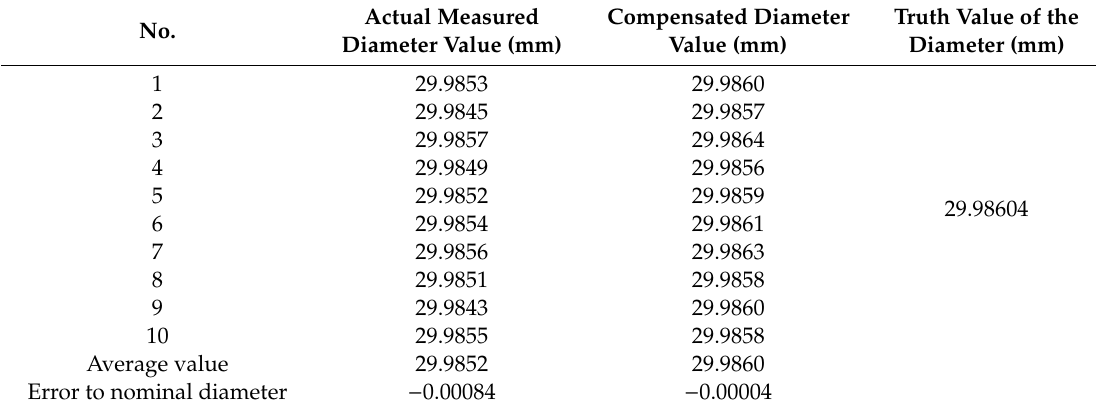
Table 1. The experimental data of the diameter of the standard sphere measured by the coordinate measuring machine (CMM) with the